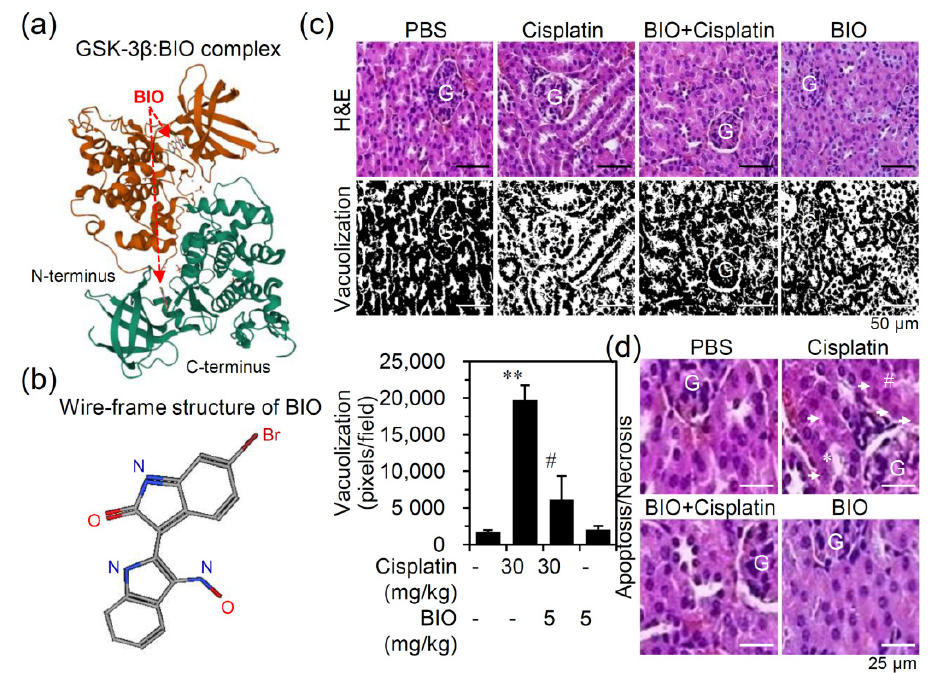
Figure 2. Inhibiting GSK-3 suppresses cisplatin-induced renal cytotoxicity. ( a ) The secondary structure of the GSK-3 β :BIO dimer complex was adapted from the RCSB PDB 1UV5. ( b ) The wire-frame structure of BIO was adapted from PubChem 833555. ( c ) Male C57BL/6 mice (n = 3) were preinjected i.p. with the GSK-3 inhibitor BIO (5 mg/kg) for 0.5 h followed by cisplatin (30 mg/kg) for 24 h. Renal pathology was characterized based on H&E staining (scale bar = 50 µm) followed by ImageJ analysis to quantify vacuolization. ** p < 0.01 compared with untreated. # p < 0.05 compared with cisplatin. ( d ) Histopathological analysis of nephrotoxicity and cellular injury, including apoptosis (arrows), necrosis (#), and vacuolization (*). For all images, a representative image set obtained from three mice is shown (scale bar = 25 µ m). G,